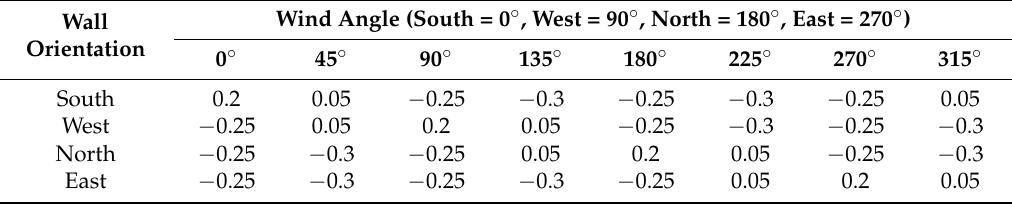
Table 8. Wind pressure coefficient according to wind